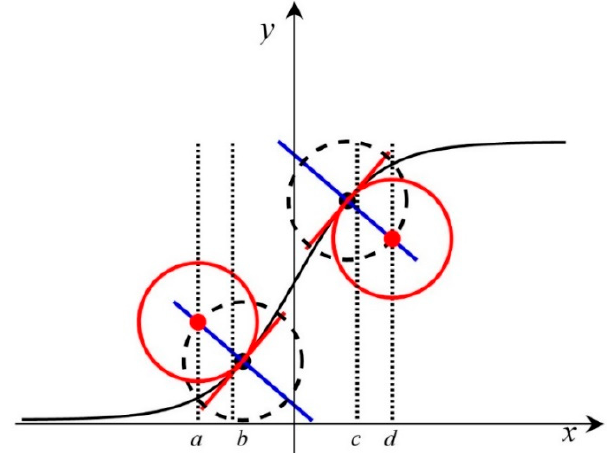
Figure 5. Illustration of the logistic function and the determination of key points of the logistic function. The curvature of the black curve reaches its maximum at the two black points. The two red circles represent the curvature circle of the two black points and the red points are the centers of red circles. The red lines are tangent to the black curve, while the blue lines are perpendicular to the red lines. The black dashed circles centered at the black points, and have the same radius as red circles have.